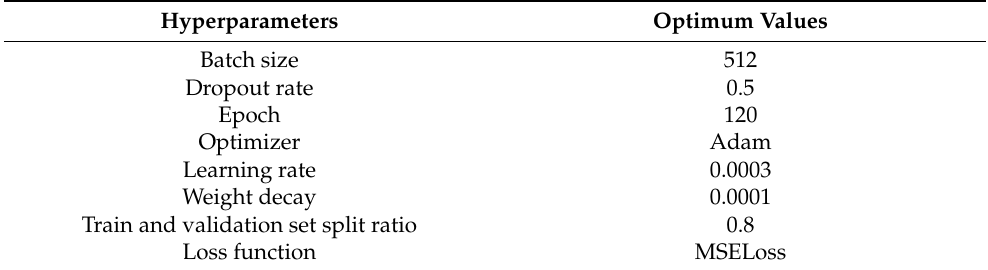
Table 2. The hyperparameters used for the LMPNet model training.